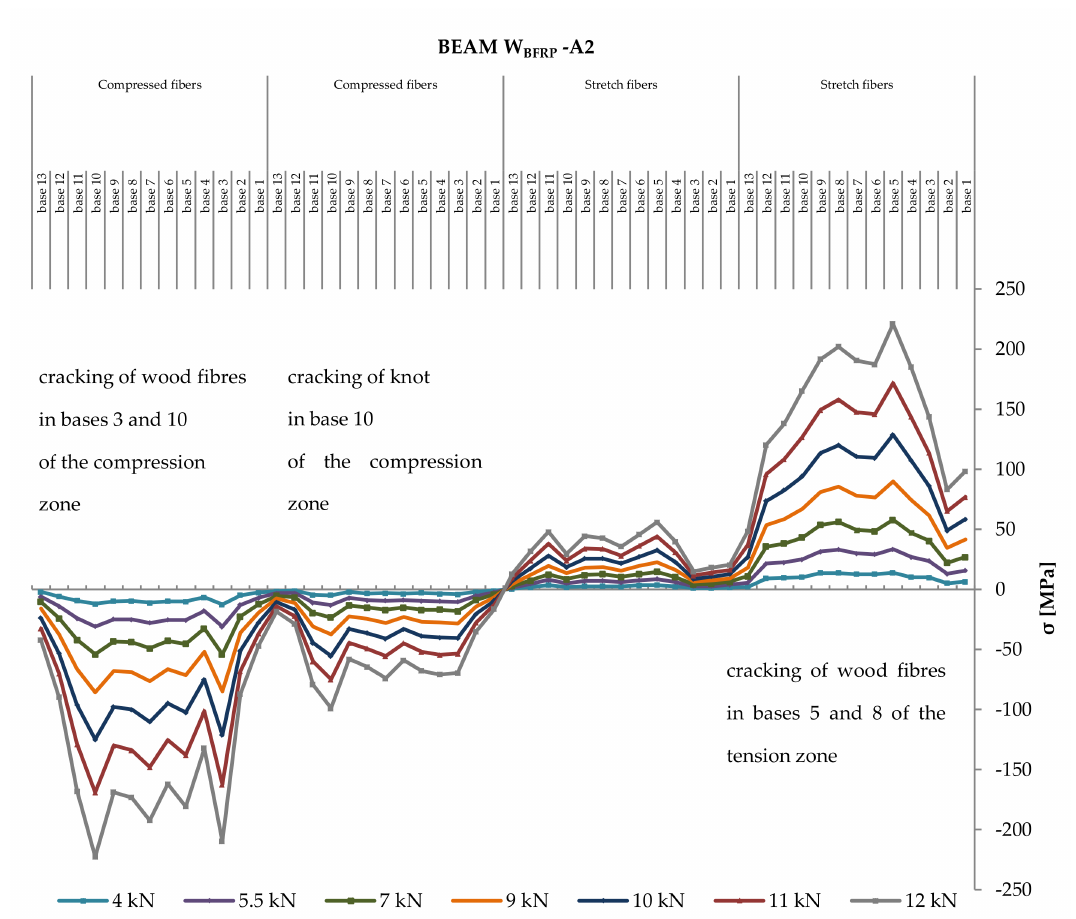
Figure 7. Distribution of normal stresses in wood σ (MPa) in the tension and compression zones of the cross-section over the entire length of a reinforced beam W BFRP -A2.